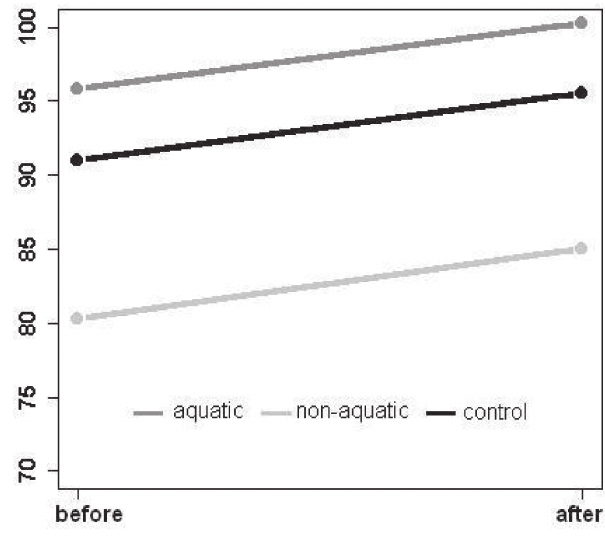
Figure 2 - EP before and after intervention. The line in boldface max indicates the average trajectory.